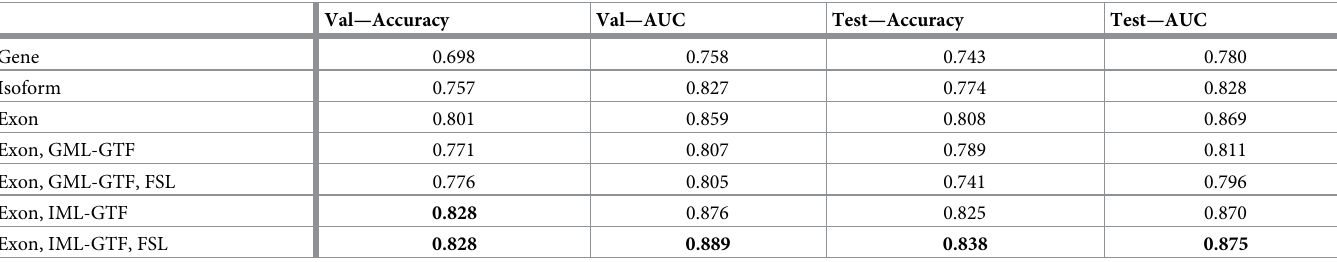
Table 2. Predictive performance of modified Beineke models using gene, isoform and exon-level expression